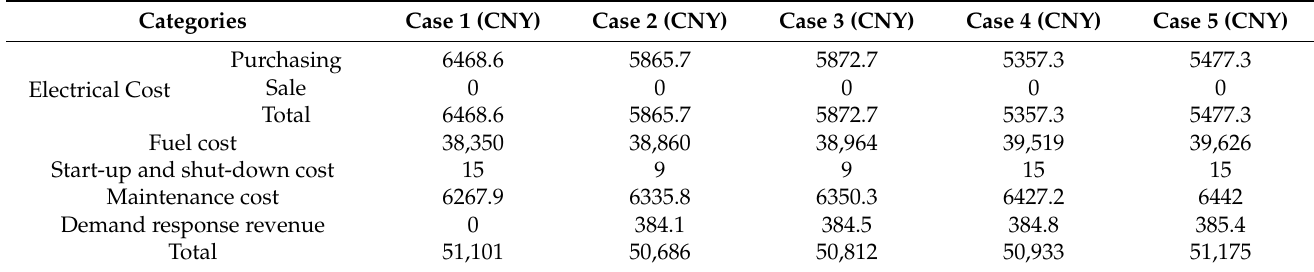
Table 8. The operating results of different PV output uncertainties.